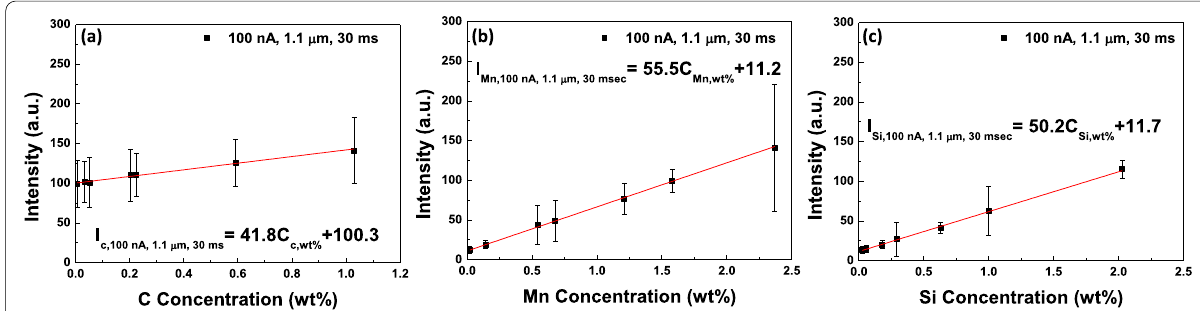
Fig. 3 Calibration curves under the condition of 20 keV, 3